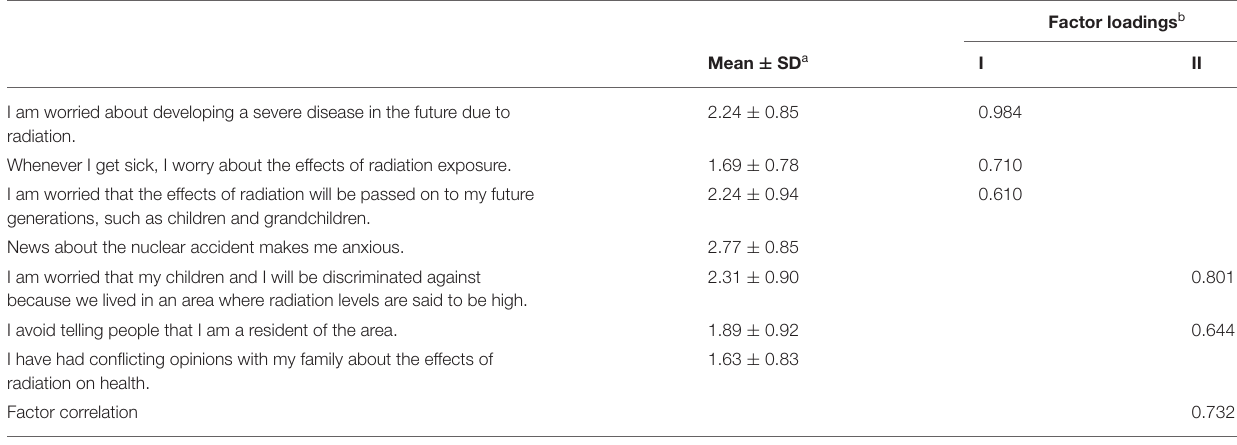
TABLE 2 | Exploratory factor analysis of the anxiety following the Fukushima